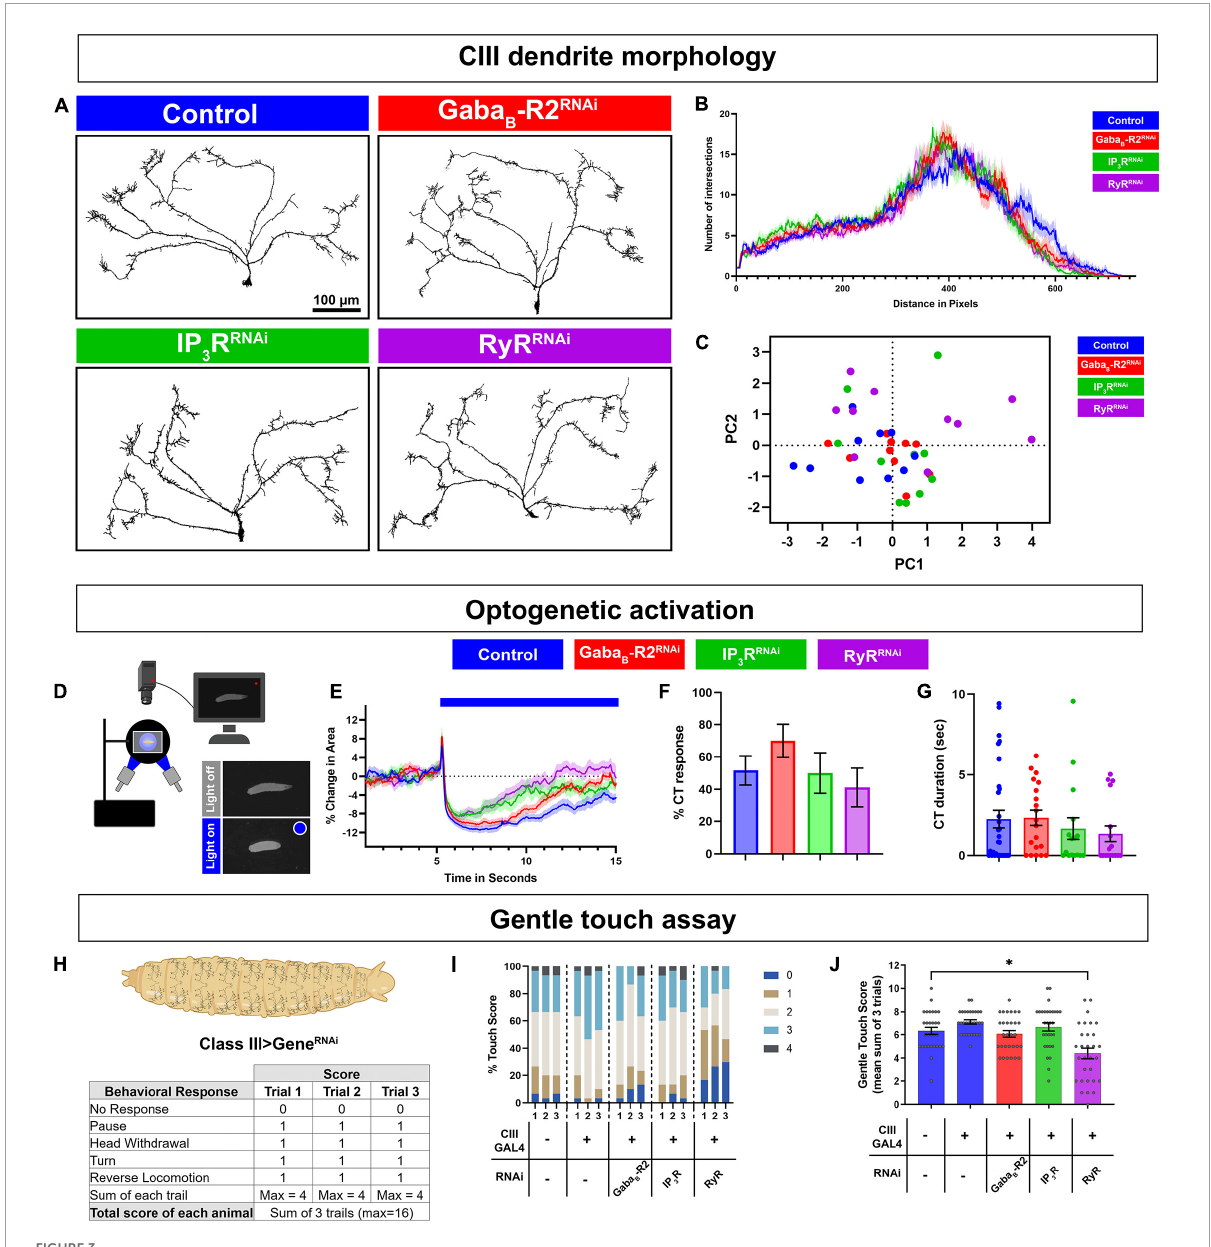
FIGURE3 G protein coupled receptor (GPCR) and CICR signaling are not required for CIII neuron dendrite development, general excitability, or neural transmission. (A – C) CIII md neuron dendrite morphometric analyses of cell type specific knockdown of GABA B -R2 , IP 3 R , or RyR . CIII md neurons were visualized using nompC GAL 4 > GFP . (A) Representative images of CIII md neuron (ddaF) dendrites with either GABA B - R2 , IP 3 R , or RyR knockdown compared to control ( Luc RNAi ). Scale bar = 100 µ m. (B) Sholl analysis of CIII md neuron dendrites, where numbers of intersections are plotted as a function of distance from the soma. (C) Principal components analysis of multiple morphometric parameters including total terminal branches, total dendritic length, branch density, max number of Sholl intersections and distance at which the max intersections occur in Sholl analyses. N Average = 10. (D – G) Neural activation of CIII md neurons using optogenetic actuator (ChETA) with cell type specific gene knockdown of GABA B -R2 , IP 3 R , or RyR . Genotype: 19–12 > ChETA + gene-specific RNAi . (D) Schematic of optogenetic stimulation apparatus. (E) Plot of change in area over time for GABA B -R2 , IP 3 R , or RyR knockdown compared to control ( Luc RNAi ). Blue bar represents 10 s of blue light exposure resulting in neural activation of CIII md neurons. (F) Optogenetic CIII md neuron activation evoked %CT response of GABA B -R2 , IP 3 R , or RyR knockdown compared to control. (G) CT duration in seconds for GABA B -R2 , IP 3 R , or RyR knockdown compared to control. (E – G) N Average = 20. Statistics: %CT response: Fisher’s exact with Benjamini-Hochberg for multiple comparison. CT duration: One-way ANOVA with Holm-Šídák’s for multiple comparisons. (H – J) Drosophila larval responses to innocuous mechanical stimulation. (H) Gentle touch assay scoring schematic. Each behavioral response receives one point and no points, if there was no response, for a maximum of four points per trial. (I) Proportion of each score per trial for each genotype. (J) Average total touch scores for each larva per genotype. N Average = 30. Statistics: Kruskal–Wallis with Benjamini, Krieger, and Yekutieli for multiple comparisons. Significant differences indicated via asterisks, where ∗ p < 0.05. Created with